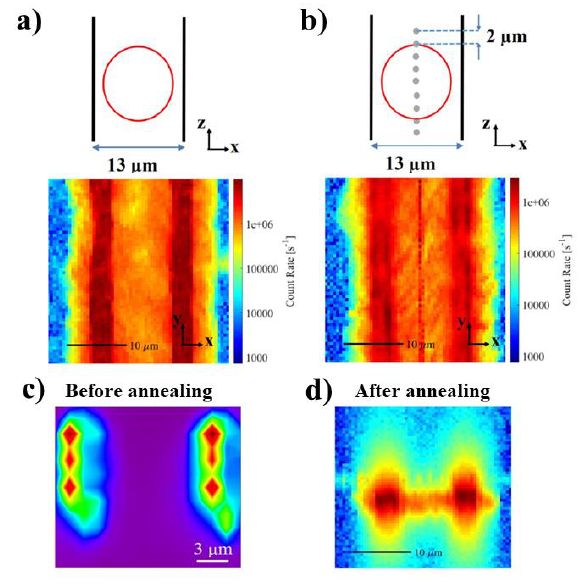
Fig. 1. Schematic cross-section of femtosecond laser written ‘empty’ (a , above ) and ‘static exposure’ (b , above) waveguides, with modification lines in black and the expected mode field diameter of the waveguide mode outlined in red, with integrated static exposures marked in gray. Photoluminescence confocal maps of ‘empty’ ( a, below ) and ‘static exposure’ ( b, below) waveguide and modification lines written in HPHT sample after annealing. PL Photoluminescence confocal cross-section of ‘empty’ waveguide and modification lines written in HPHT sample before (c) and after (d)